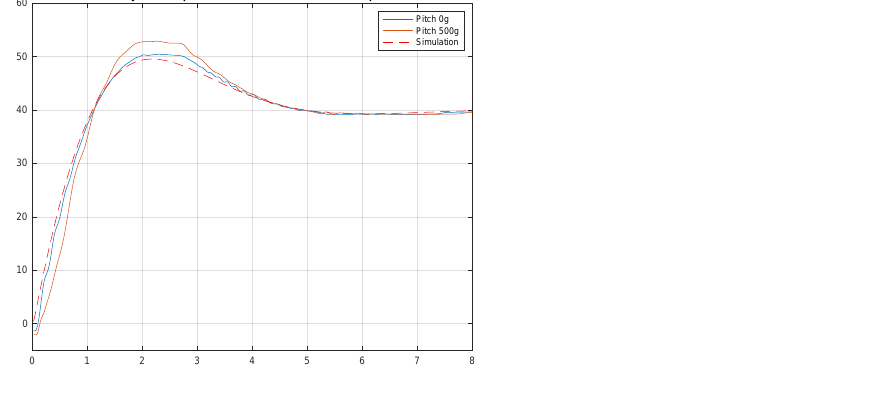
Figure 9. System response with the PI controller for a pitch step reference of α = 40 ◦ and a constant yaw angle of β = 0 ◦ . Control specifications: φ m = 60 ◦ and ω gc = 1.5 rad/s.